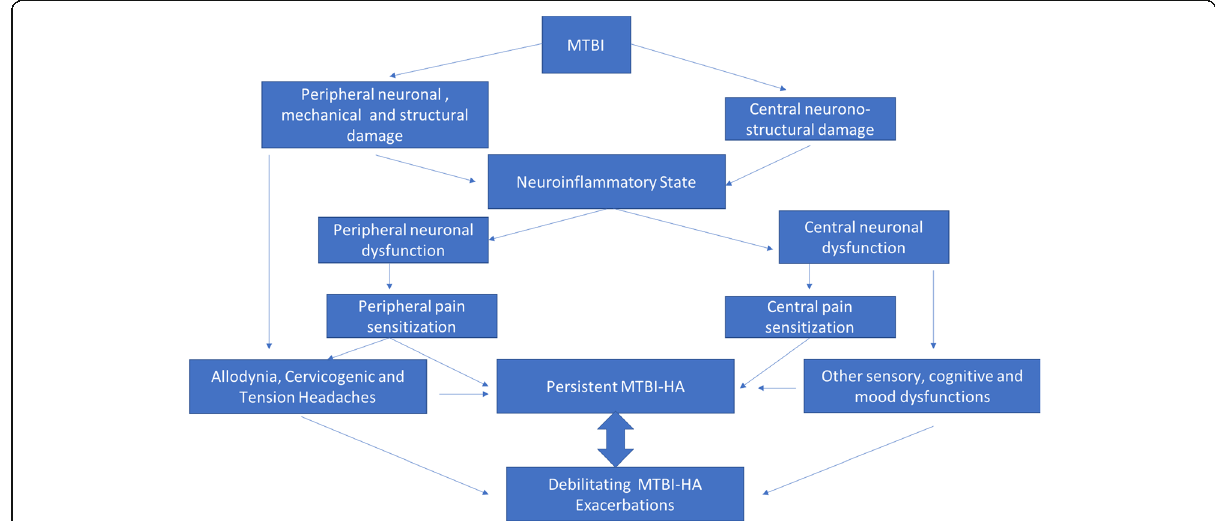
Fig. 1 Proposed post-injury mechanisms leading to the development of mild traumatic brain injury related headaches (MTBI-HA) as a neuropathic pain state; MTBI: mild traumatic brain injury; MTBI-HA: MTBI related